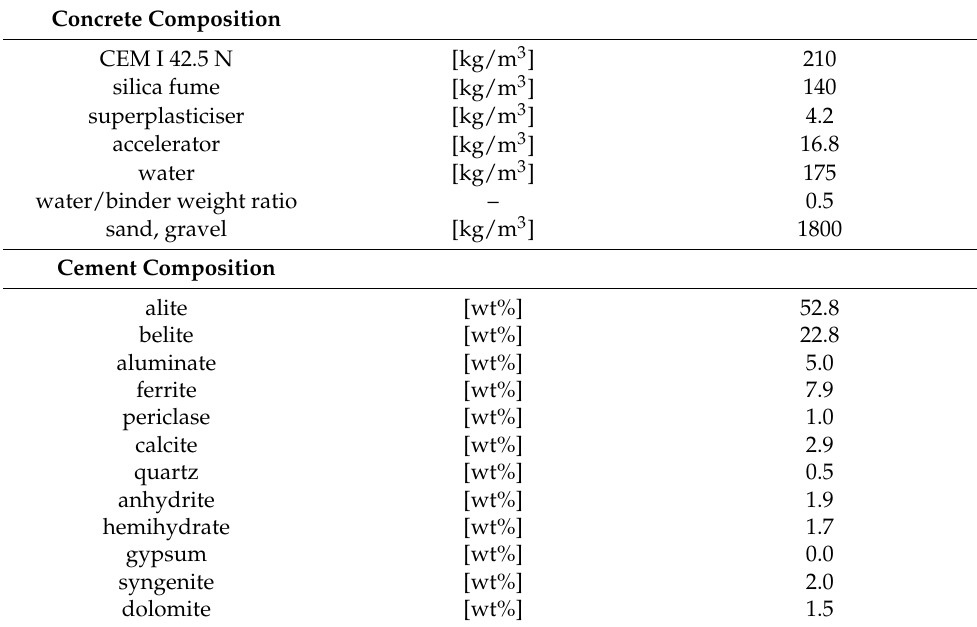
Table 1. Characteristics of concrete and cement. Binder represents all reactive components (cement, silica). Cement composition was determined by XRD Riedtveld analysis using an internal